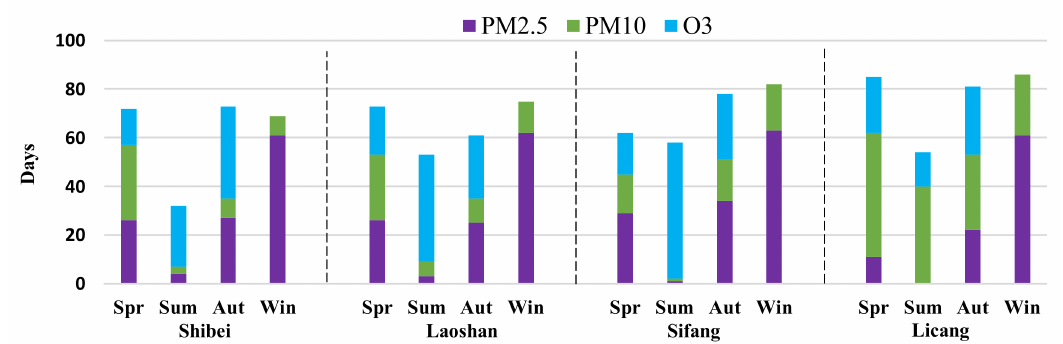
Figure 5. Chart showing the number of days of the dominant air